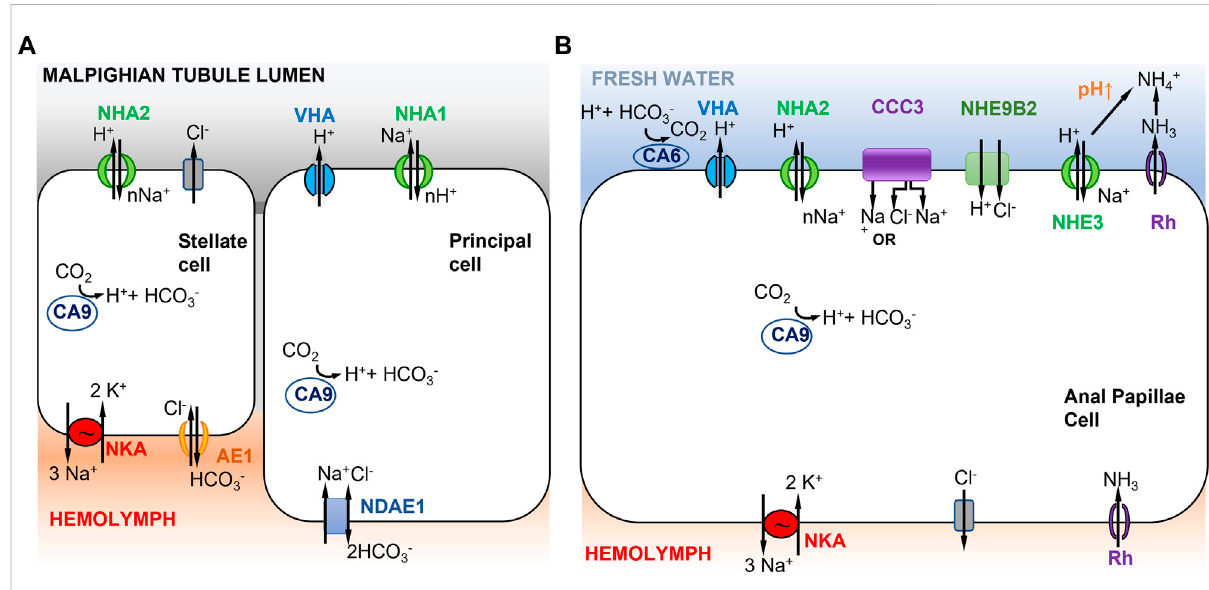
FIGURE 3 Models of ion uptake by mosquito larvae in freshwater habitats. (A) Model of Na + transport in distal Malpighian tubules of mosquito larvae. V-type H + ATPase (VHA) in the apical membrane of principal cells co-localizes with NHA1 (1Na + out to nH + in) and generates a positive voltage that energizes transportevents across theapical membrane. The basolateral membraneoftheprincipal cellscontains Na + dependentanion exchanger 1 (NDAE1), which translocates 1Cl - and 1Na + into the cells and 2HCO 3 − out. NHA2 in the apical membrane of stellate cells has a proposed stoichiometry of nNa + in and 1H + out. The basolateral membrane of the stellate cell contains Na + /K + -ATPase (3Na + out and 2K + in) and anion exchanger AE1 (1Cl - in and 1HCO 3 − out). Adapted from Xiang et al. (2012). (B) Model of Na + uptake from the external freshwater environment in anal papillae of mosquito larvae. Both Model 1 (Figure 1A) and Model 2 (Figure 1B) are operating here (see text). CCC3 might function as a Na + ,Cl − cotransporter or Na + transporter. NHE9B2 is homologous to Drosophila NHA1, which might function as a H + ,Cl − cotransporter (Chintapalli et al., 2015) or as a Na + /H + antiporter. Adapted from Durant et al.